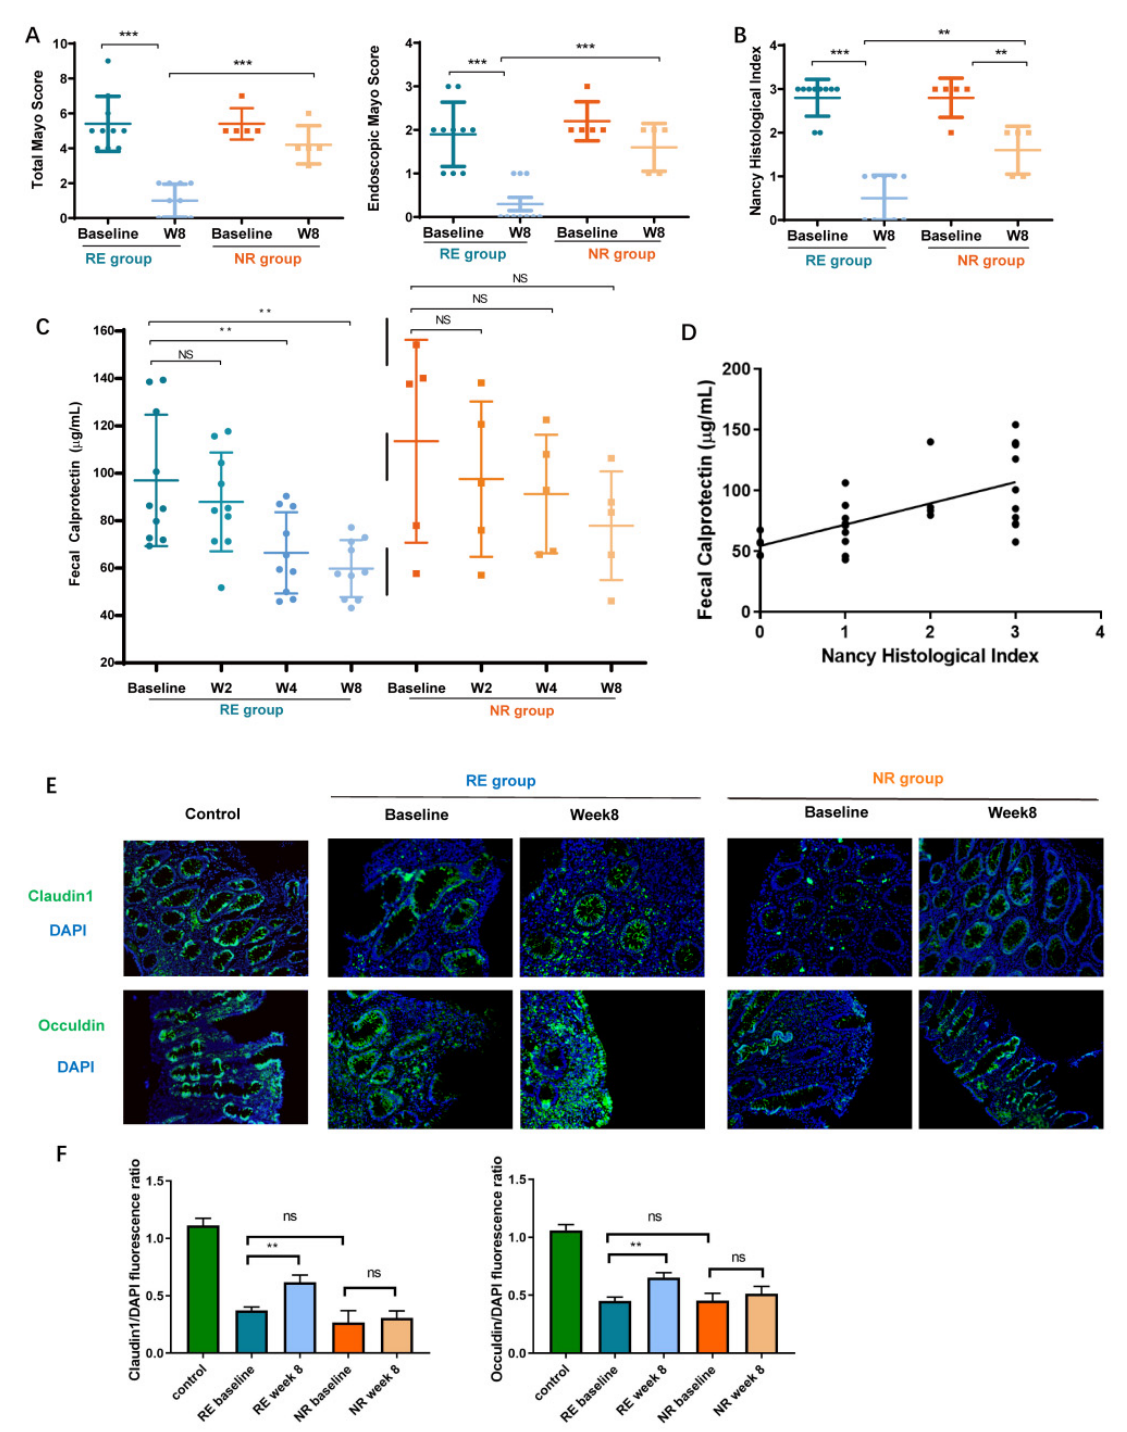
Figure 2. Fecal microbiota transplantation (FMT) improved the ulcerative colitis (UC) patients with intestinal inflammation and intestinal barrier function. ( A ) The total and endoscopic Mayo scores. ( B ) The Nancy histological index. ( C ) The level of fecal calprotectin in multi-time points. ( D ) Correlation of fecal calprotectin with Nancy histological index (r = 0.645, p = 0.0002) ( E ) The Claudin1 and Occuldin protein expression in colon by immunofluorescence. ( F ) Fluorescence ratio of Claudin1 and Occludin in all groups to DAPI were presented. Each bar represents mean ± SEM. One-way ANOVA followed by Student-Newman-Keul’s test was used for multiple-group comparisons. (ns > 0.05, ** p < 0.01, *** p < 0.001) (RE, responders; NR, non-responders).